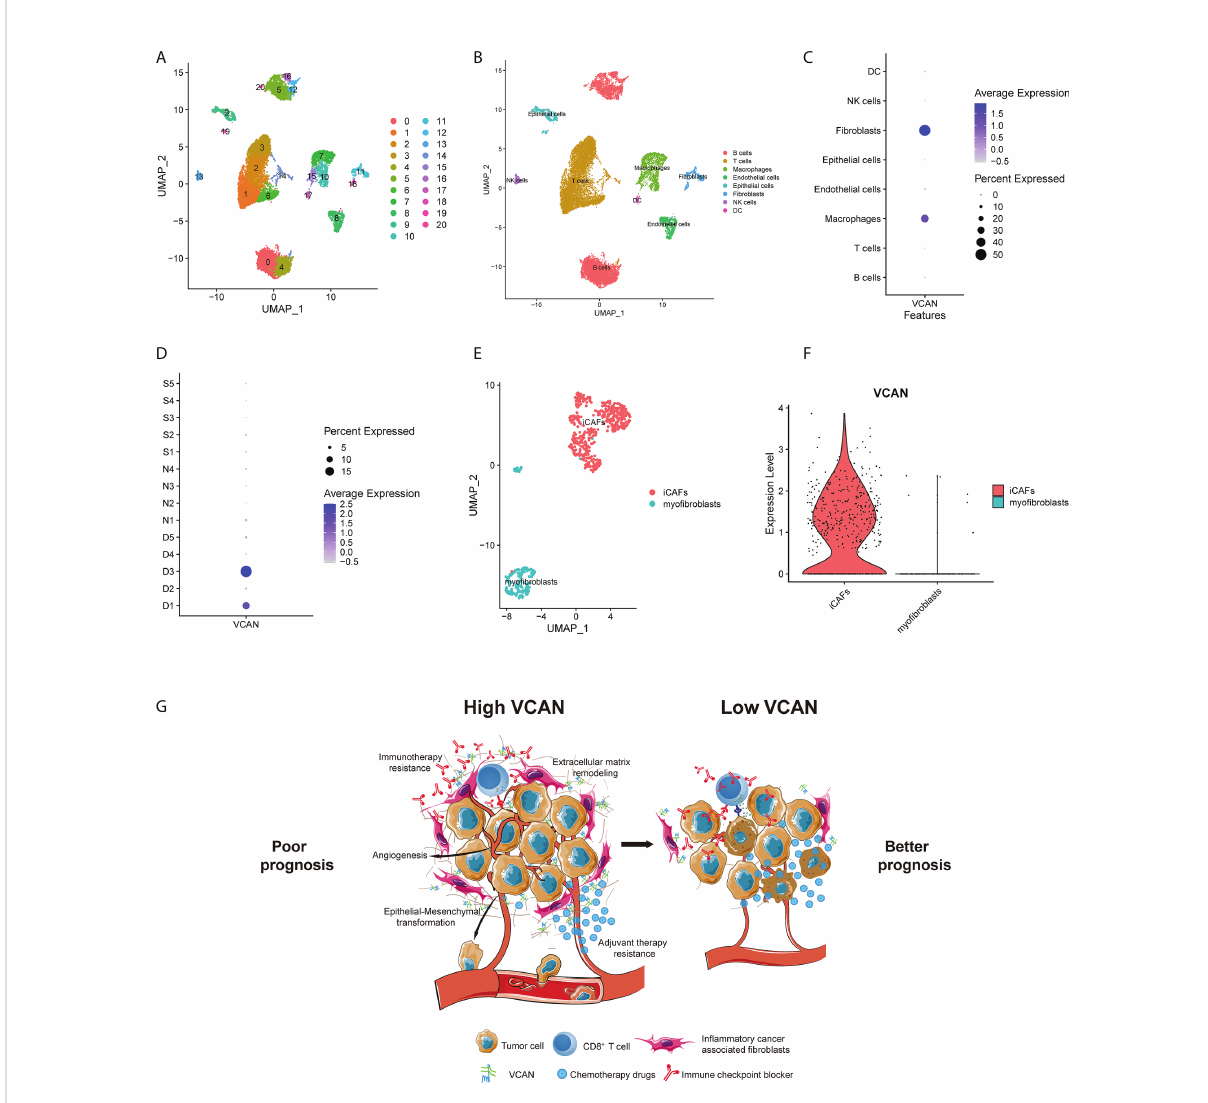
FIGURE 6 The single cell location of VCAN in the tumor microenvironment. (A) UMAP plot showed 21 cell clusters from 19765 cells of patients in GSE167297. (B) UMAP plot showed eight cell types from 19765 cells of patients in GSE167297. (C) Dotplot showed the expression level of VCAN in different cell types in GSE167297. (D) Dotplot showed the expression level of VCAN in deep layer (D1, D2, D3, D4, D5) and super fi cial layer (S1, S2, S3, S4, S5) of tumor tissues and paired normal tissues (N1, N2, N3, N4) in GSE167297. (E) Subpopulation analysis aimed to fi broblasts of patients in GSE167297. (F) Violin plot showed the expression of VCAN in iCAFs and myo fi broblasts in GSE167297. (G) Graphic summary of the proposed model. VCAN secreted by iCAFs was involved in the activation of stroma related pathways, thereby promoting anti-tumor therapy resistance. iCAFs: in fl ammatory cancer associated fi